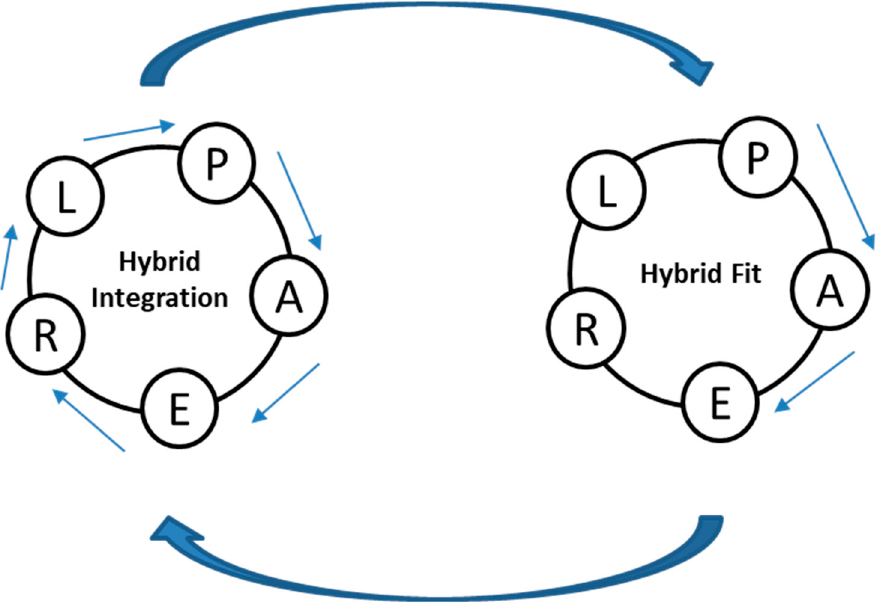
Figure 6. Case 2 iterations proceeded back and forth when solving the power production demanded by the digital environment.